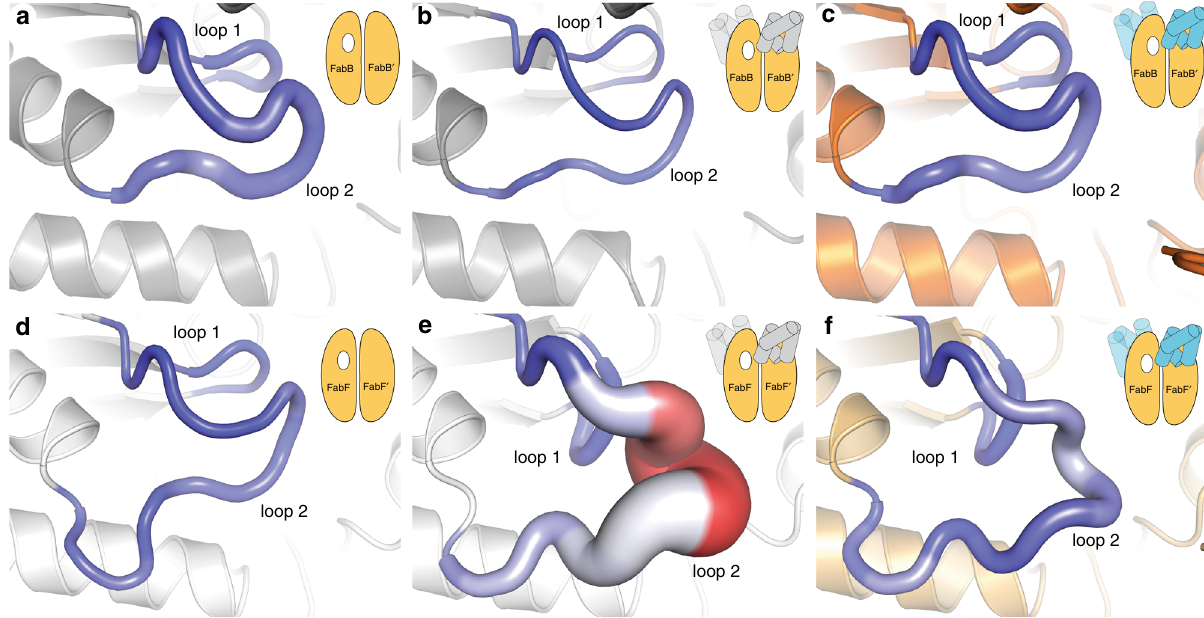
Fig. 7 Loop dynamism sampled via computer simulations. Per residue root mean square fl uctuations (RMSFs) of a , apo -FabB 2 ; b apo -FabB 2 * ( apo structure derived from AcpP 2 – FabB 2 structure); c AcpP 2 ·FabB 2 ; d apo -FabF 2 ; e apo -FabF 2 * ( apo structure derived from AcpP 2 -FabF 2 structure); f AcpP 2 ·FabF 2 . Larger (per residue) backbone RMSF values correspond to a thicker “ sausage ” ; color range (blue to white to red) illustrates (per residue) side chain RMSFs with the blue-to-red color range indicating small-to-large RMSF